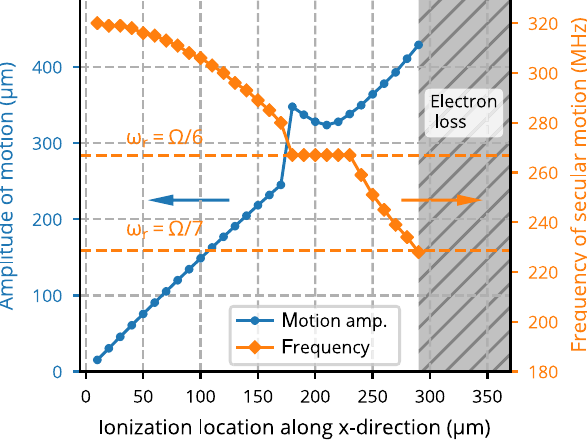
10. Amplitude (left axis, blue dots) and frequency (right axis, orange diamonds) of electron motion as a function of ionization location for a microwave drive phase of ϕ ¼ 0 . 35 × π at ionization. The orange dashed lines indicate subharmonic resonance frequencies. Electron motion becomes unstable when the secular frequency reaches the seventh subharmonic, corre- sponding to a motion amplitude of about 420 μ m. For ionization increase in the motion amplitude.